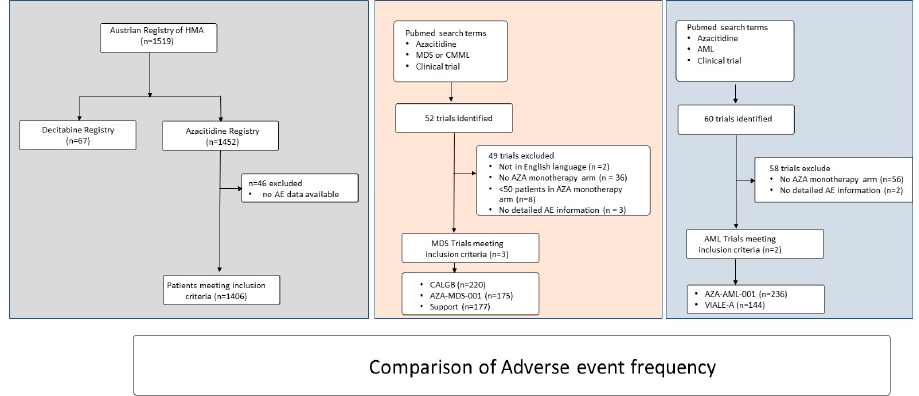
Figure 1. Consort diagram. Figure 1. Consort Table 1. Characteristics of patients included in the Austrian Registry of Hypomethylating Agents at azacitidine treatment start.